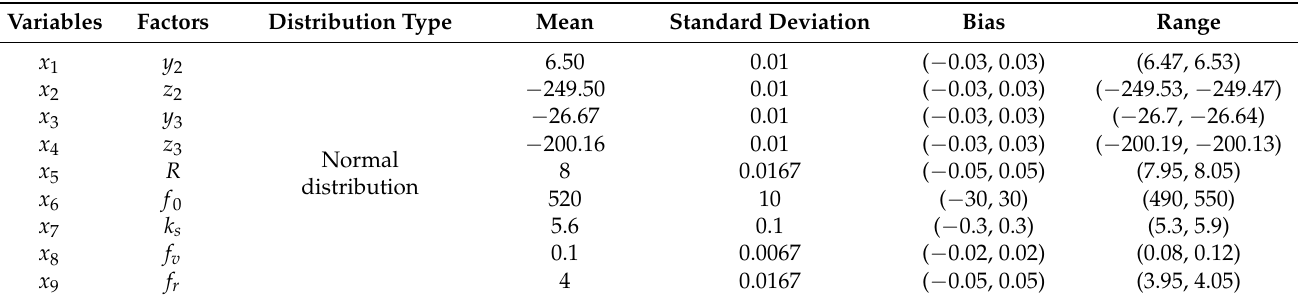
Table 2. Variables and their